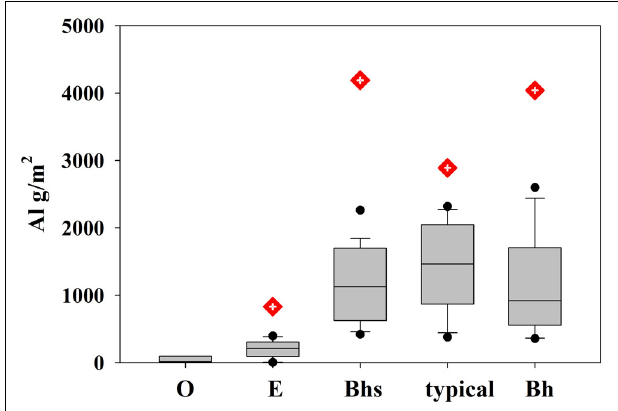
FIGURE 10 | Box plots showing the distribution of salt extractable pools of aluminum (Al) stratified by soil type. The number of profiles used for pool size estimates was O = 6, E = 14, Bhs = 19, typical = 11, Bh = 11. For comparison, the mean soil pool of oxalate extractable Al in each soil type (Bourgault, 2014) is also